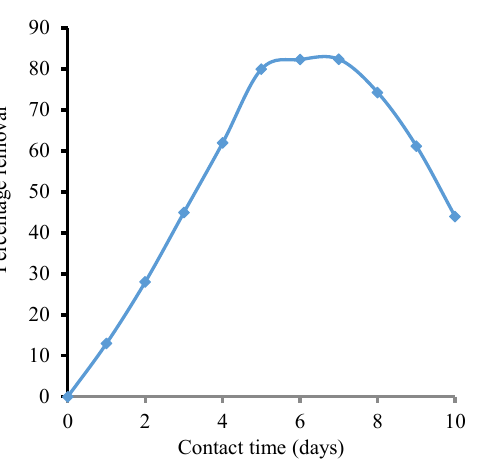
Fig. 2: COD removal percentage for the run 2 Fig. 3: Voltage production for the run 5